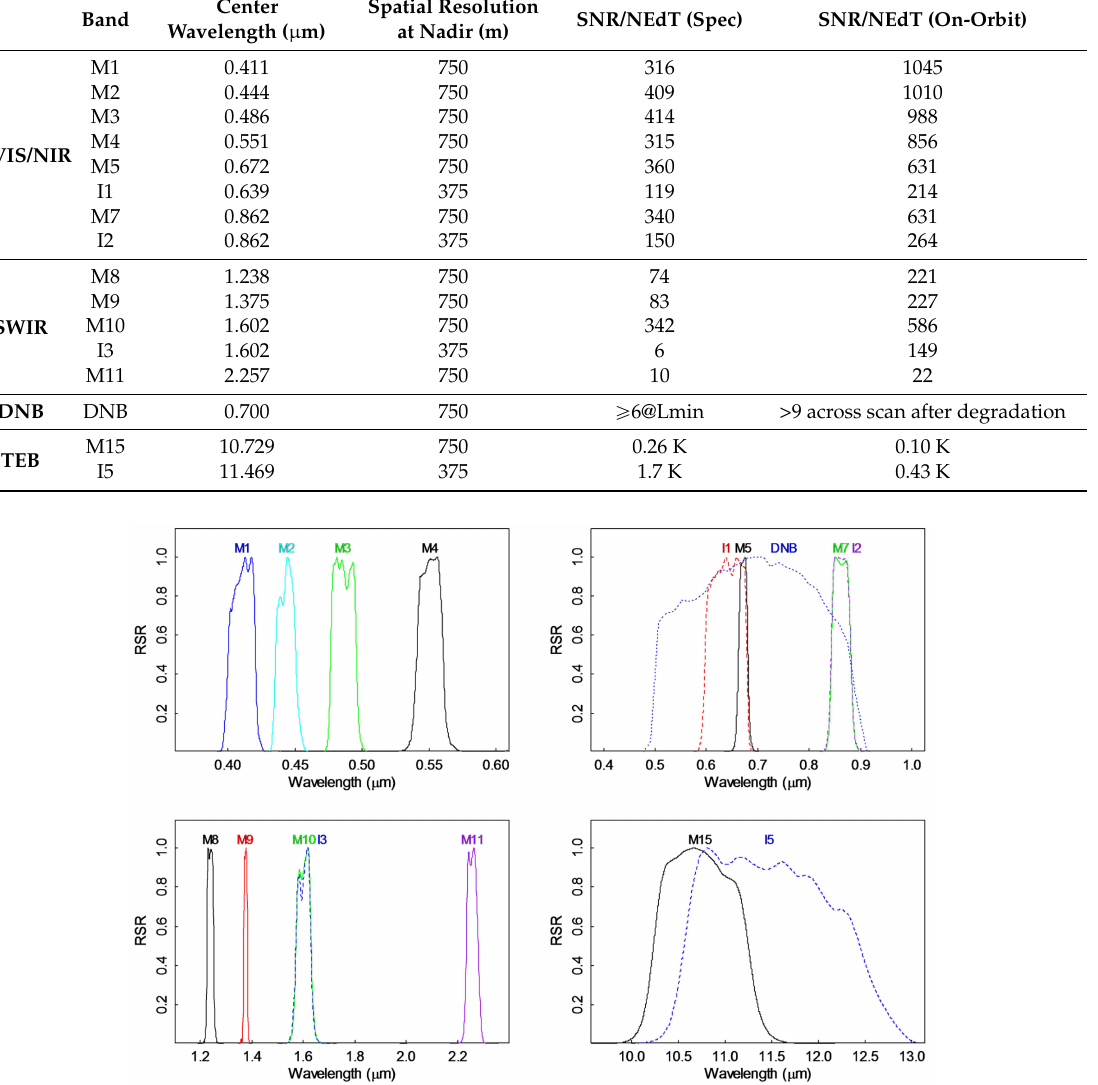
Figure 1. Relative spectral response functions (RSR) of all VIIRS bands used in this